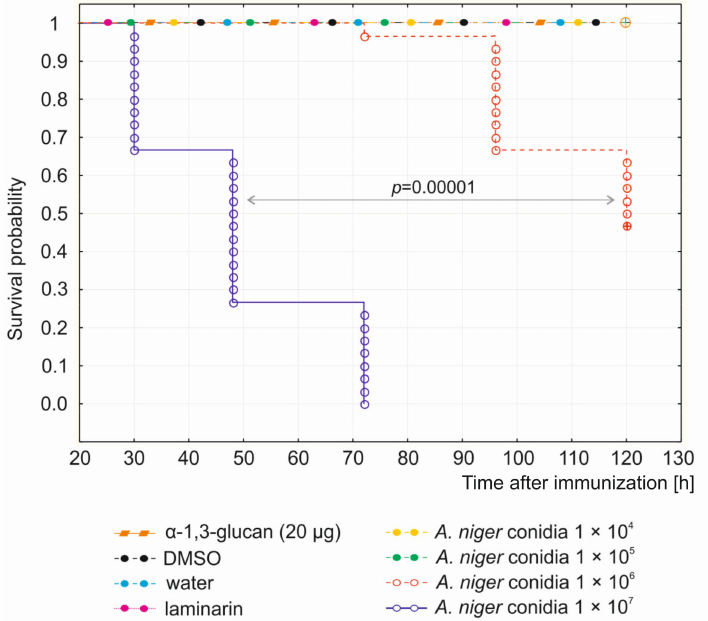
Figure 1. Survival analysis of G. mellonella larvae treated with A. niger α -1,3-glucan, A. niger conidia, or laminarin. The larvae (30 larvae per group) were injected with A. niger α -1,3-glucan (doses 1 µ g, 5 µ g, 10 µ g, 20 µ g), and indicated doses of A. niger conidia or laminarin (50 µ g). The control larvae were injected with DMSO or water as described in the Materials and Methods. The probability of survival was estimated with the Kaplan–Meier method with the log-rank test. A. niger α -1,3-glucan in every dose used had no effect on larval survival; hence, only the survival probability after the highest dose (20 µ g) used is presented.